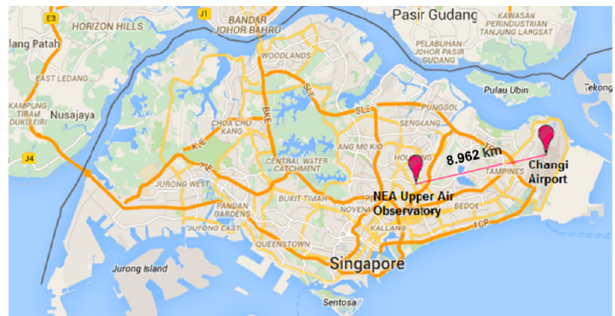
Figure 1. Site locations of Changi airport and NEA upper air observatory.